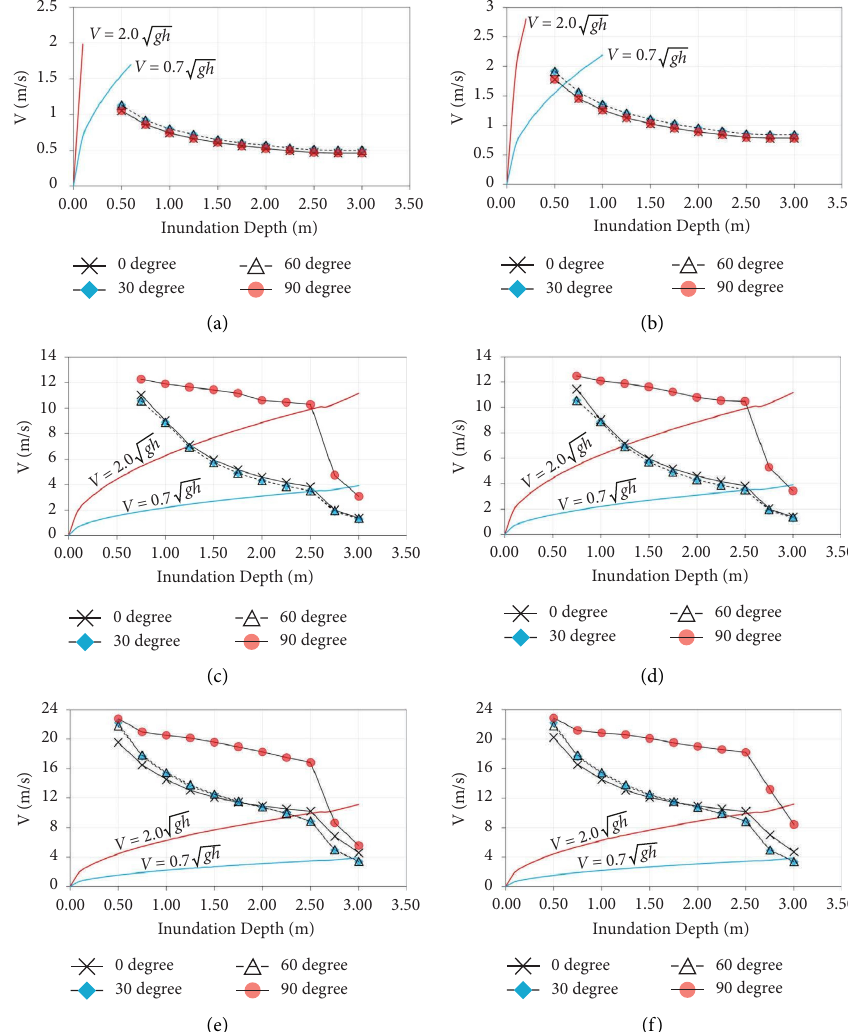
Figure 12: Damage data at each inundation depth within the tsunami fow velocity boundary. (a) DL1 with HW. (b) DL1 with CW. (c) DL2 with HW. (d) DL2 with CW. (e) DL3 with HW. (f) DL3 with CW.